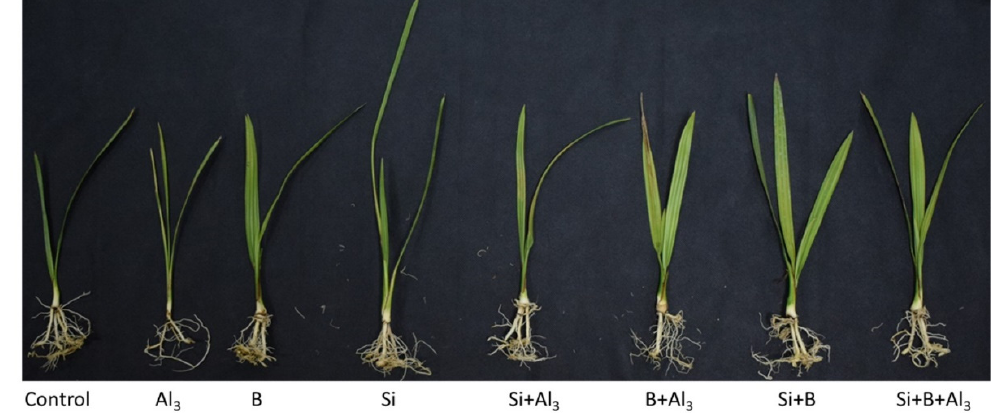
Figure 1. Application of sole silicon (Si) and Boron (B) and their integrative effects on date palm growth under Al stress.